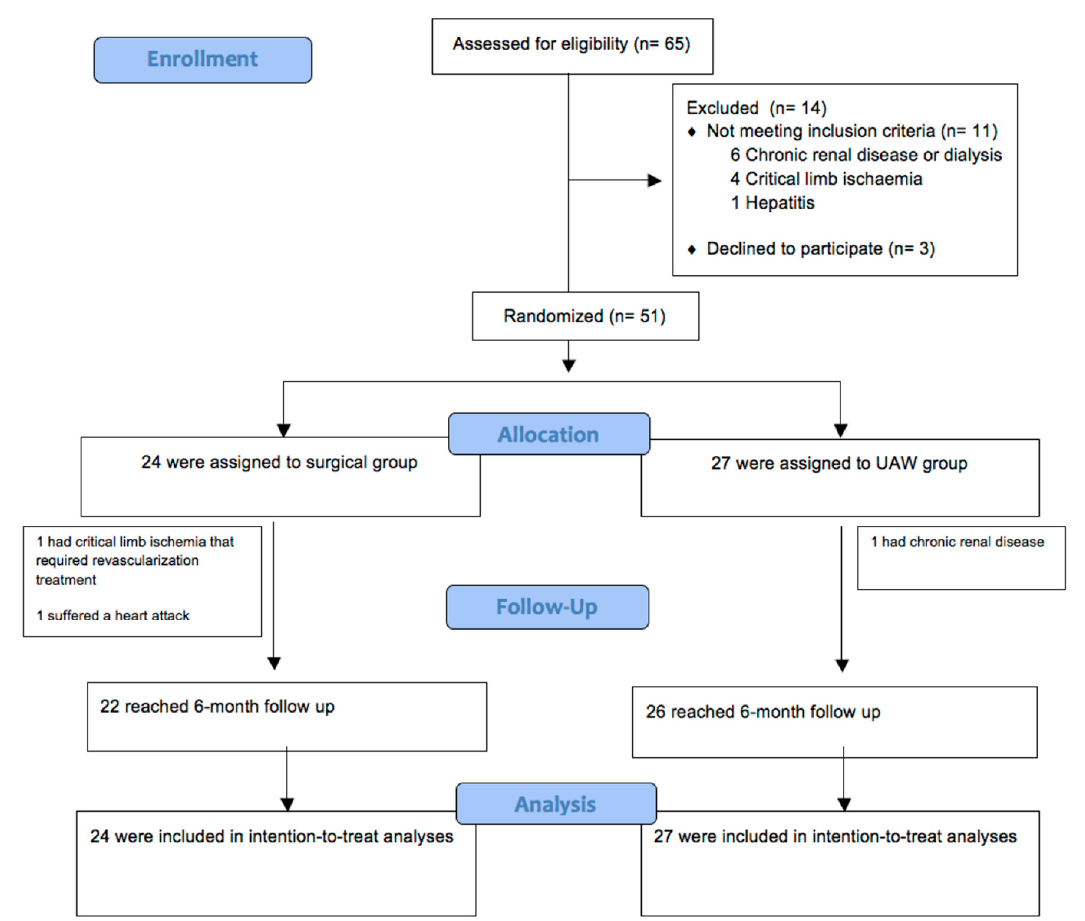
Figure 4. Study flow diagram.